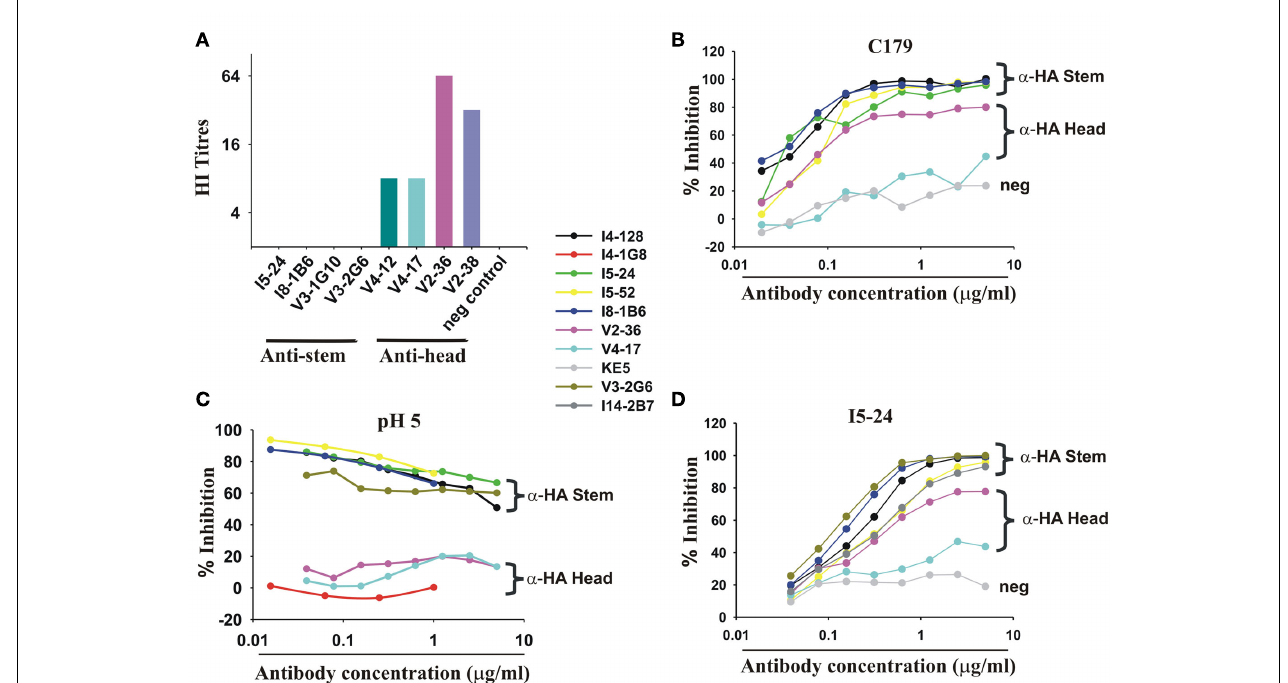
pre-treatment of HA selectively decreases binding of anti-HA stem mAbs whether encoded by IGHV1-69 or other IGHV genes (like I5-52) but not anti-HA head mAbs likeV2-36. (D) ELISA showing competitive inhibition of the indicated mAbs of the binding of biotinylated I5-24, which uses IGHV1-69 and binds to the HA stem. Note thatV2-36 also inhibits binding of I5-24. Also shown is competitive inhibition of I5-24 binding by I14-2B7, which uses IGHV1-18 and IGKV2-30. KE5, an human anti-HCMV monoclonal antibody (McLean et al., 2005), was used as a negative